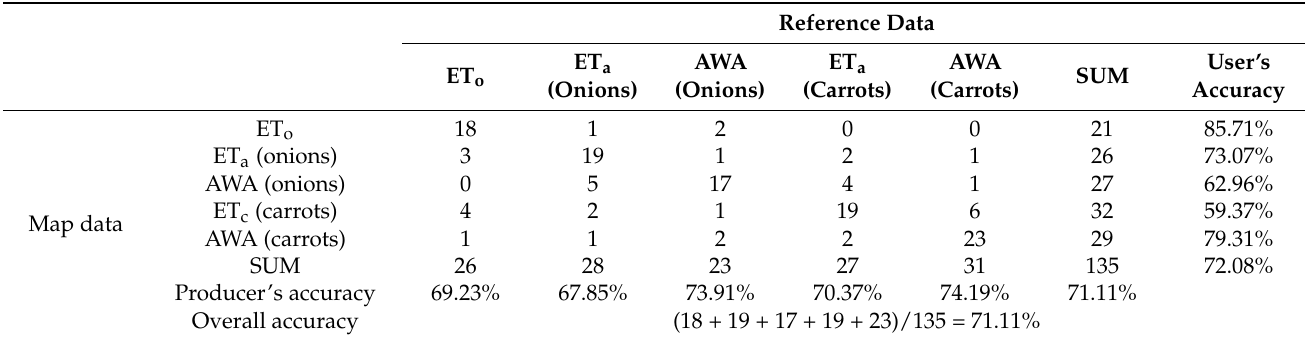
Table 6. Accuracy assessment of the generated CWU (i.e., ET a ) map against the amount of water actually applied